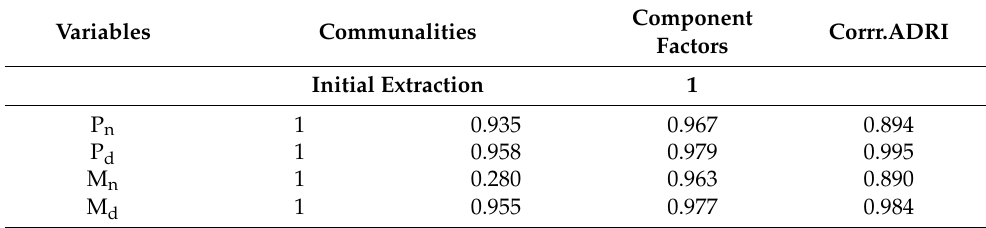
Table 2. Principal component analysis of the Agricultural Drought Resilience Index. Component Corrr.ADRI Variables Communalities Factors Initial Extraction 1 P n 1 0.935 0.967 0.894 P d 1 0.958 0.979 0.995